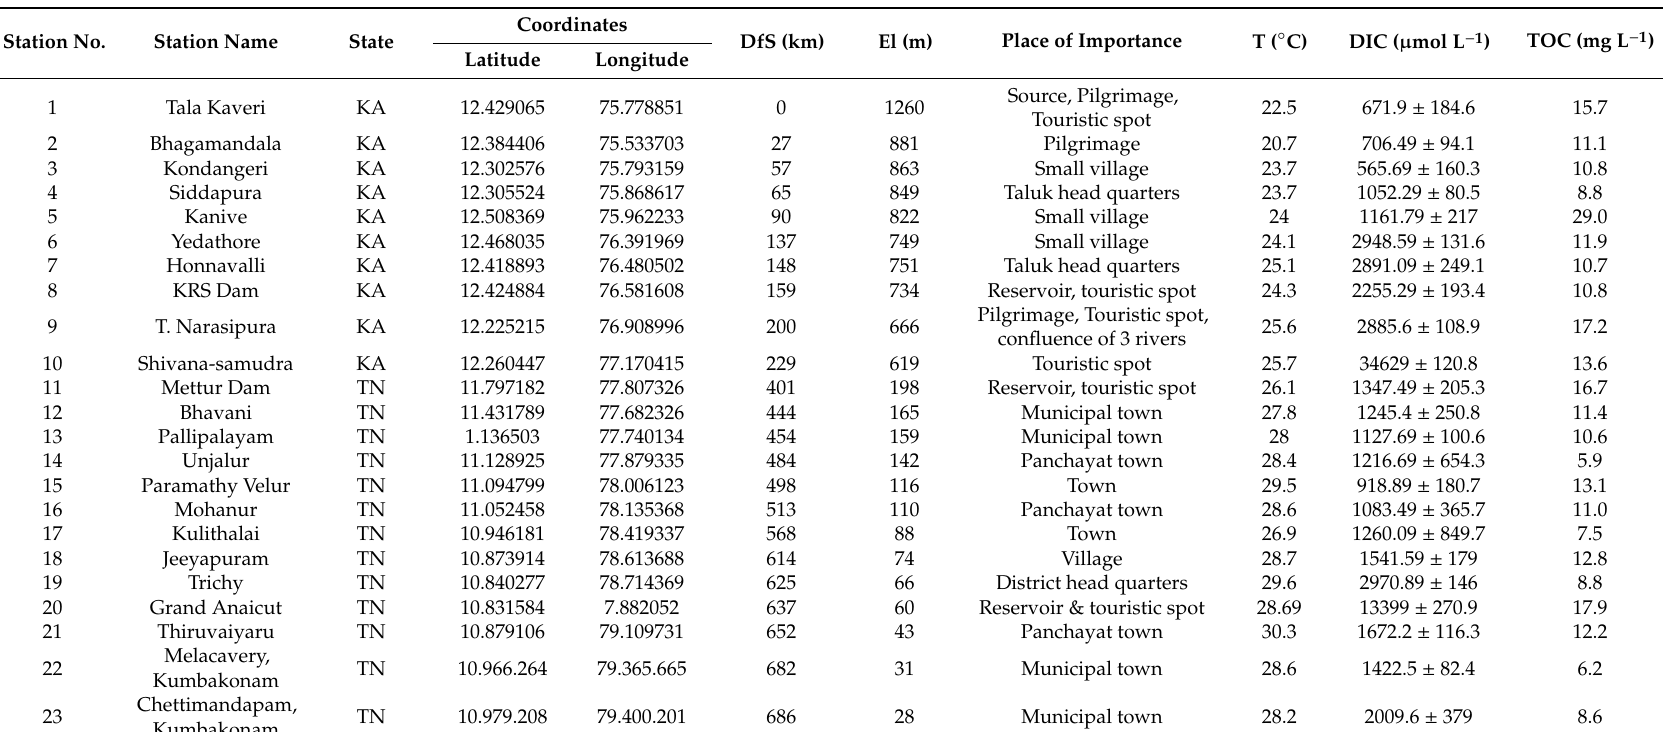
Table 1. Number, name, district, state (to which each station belongs), geographical coordinates (latitude and longitude), distance (of other stations from Station 1, point of origin), elevation (in m a.s.l.), place of importance, temperature ( ◦ C), dissolved inorganic carbon concentration (DIC, mmol L − 1 ), and total organic carbon concentration (TOC, mg L − 1 ) of each station along the Cauvery River basin, India, during winter (January 2016). TN = Tamil Nadu; KA = Karnataka; St-No = station number; DfS = Distance from Source (in km); NA = Not available. Station